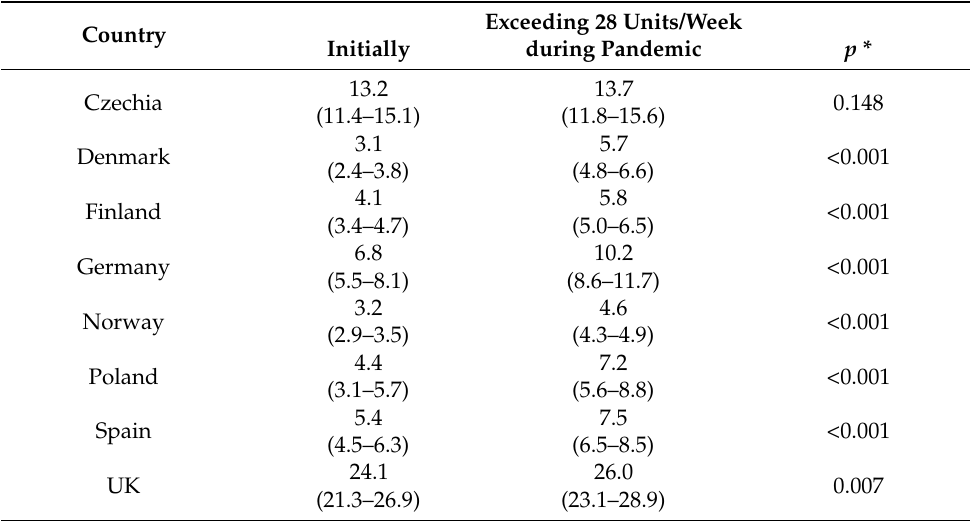
Table 3. Estimated proportion of heavy drinkers initially and during the pandemic, by country. Percent (95% CI).